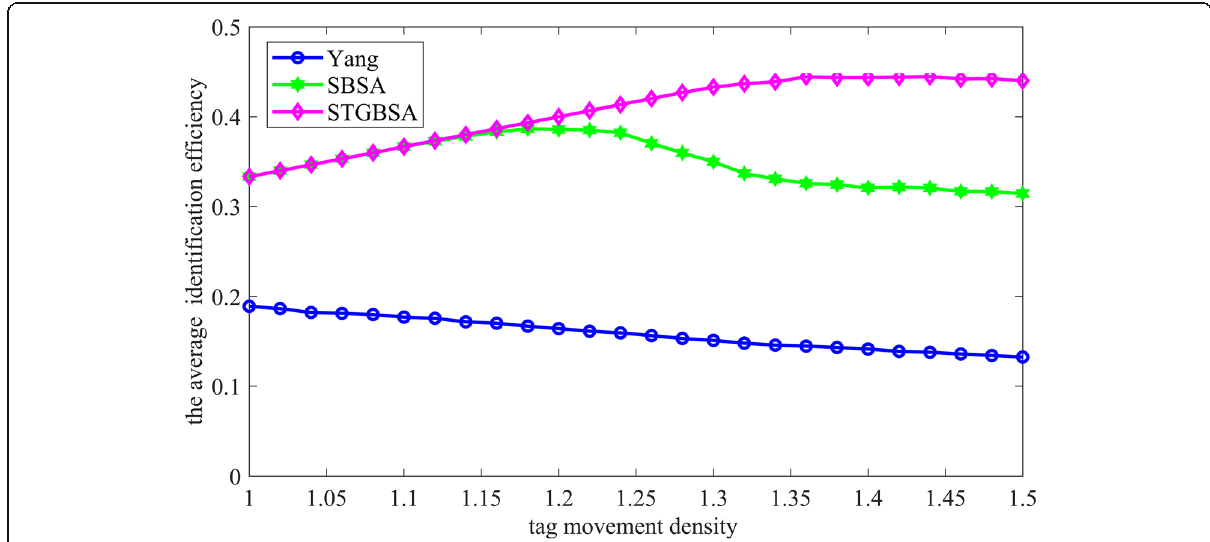
Fig. 16 Comparison of IE at high